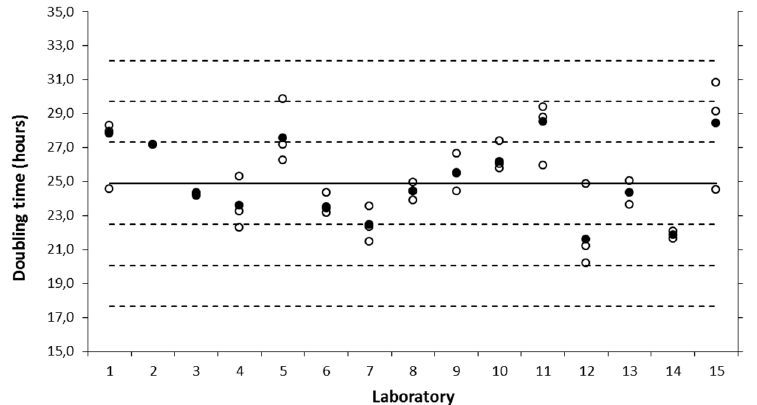
Figure 1. Inter-laboratory evaluation of growth rate of the A549 cell line (tier 1). Three (some 2) independent runs (indicated with open circles) were performed in each laboratory to determine the cell doubling time. The mean of each lab (filled circles), and overall mean (N = 15; black solid line) with 1-, 2- or 3-fold of the overall standard deviation (SD) (black dotted lines) are indicated.